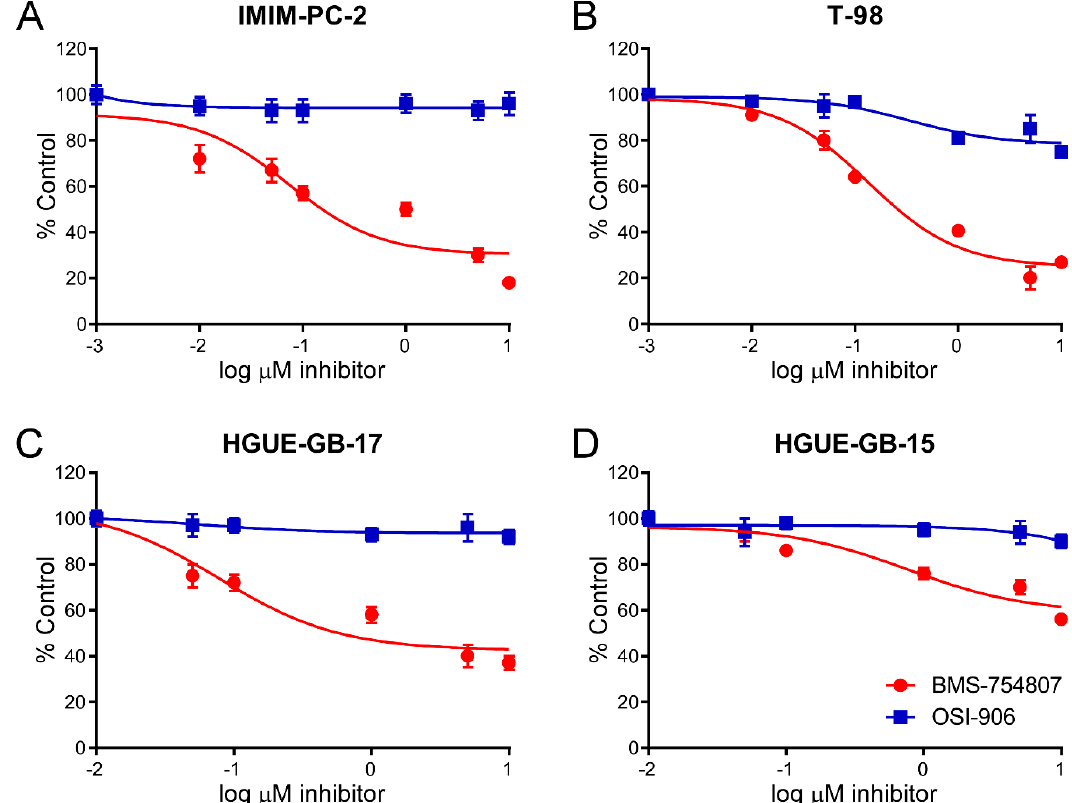
Figure 3. Dose–response effect of BMS-754807 and OSI-906 on cell proliferation in different tumor cell lines. The indicated cell lines were treated with 0.01–10 µM BMS-754807 or OSI-906 for 72 h and cell proliferation was evaluated by the MTT assay. ( A ) IMIM-PC-2 pancreatic carcinoma cell line; ( B ) T98 glioblastoma cell line; ( C , D ) HGUE-GB-17 and HGUE-GB-15 glioblastoma primary cultures, respectively. The solid line of each plot has been calculated by fitting the three parameters of a sigmoid equation (dose–response curve) on the data that represent the decimal logarithm of the inhibitor concentration versus the response obtained. GraphPad Prism 5 software (GraphPad Software Inc., San Diego, CA, USA) has been used. Data represent the mean ± SEM (n ≥ 6) of viable cells percentage with respect to untreated controls, taken as